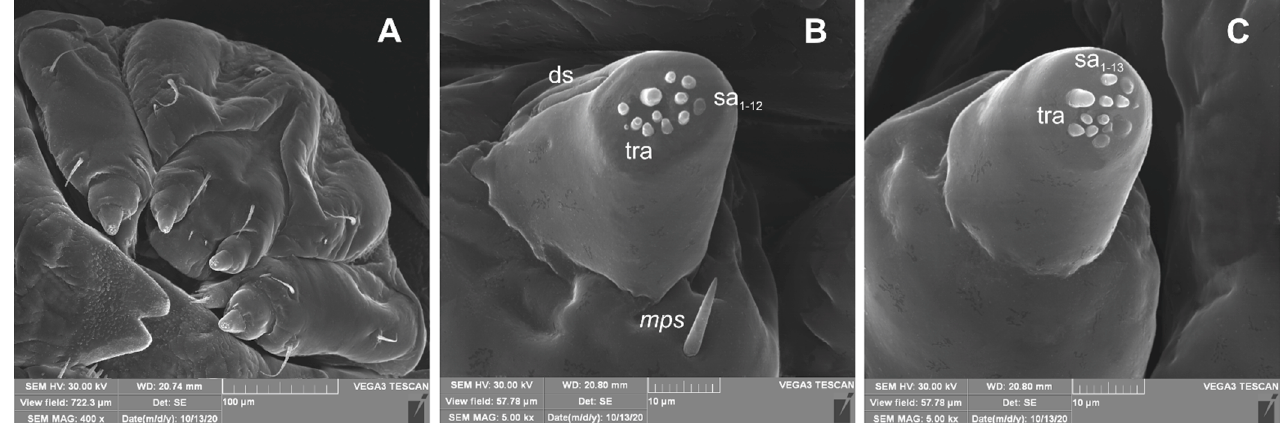
Figure 18. Rhinocyllus alpinus mature larva, maxillolabial complex, SEM photo. ( A ) — maxillolabial complex, ventral aspect; ( B ) — apical part of maxillary palp; ( C ) — apical part of labial palp (ds — digitiform sensillum, sa — sensillum ampullaceum, sb — sensillum basiconicum, tra — terminal receptive area).